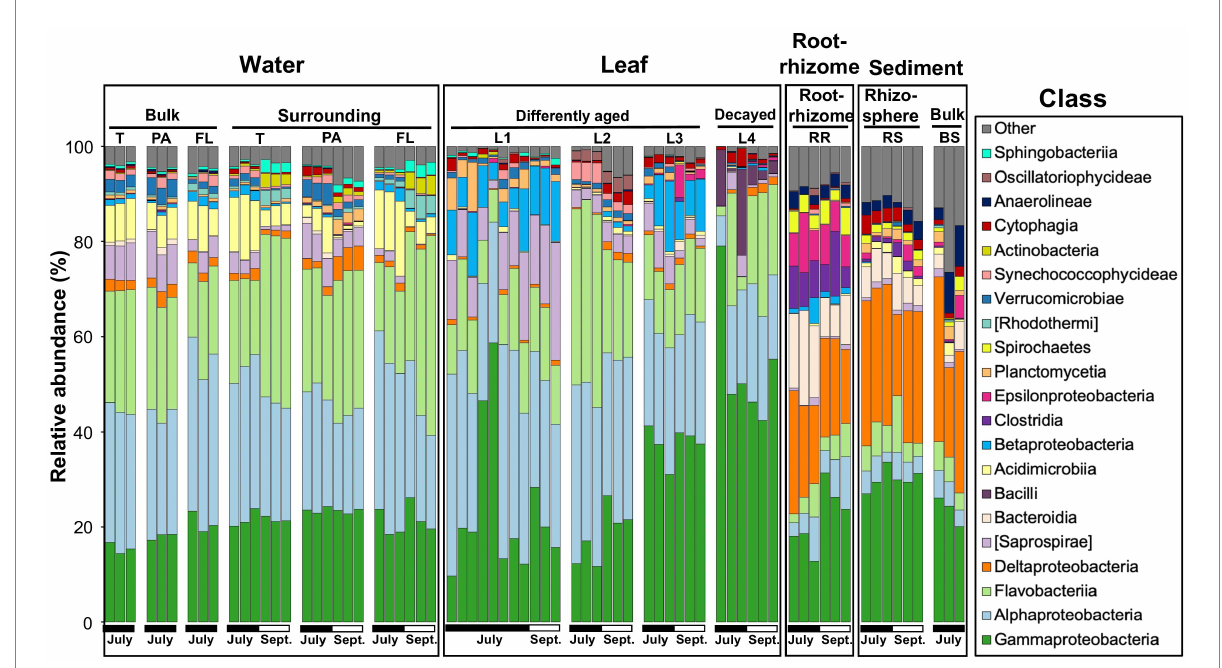
FIGURE 2 Microbial community composition of the eelgrass phyllosphere (differently aged and decayed leaves), rooting zone (the root-rhizome), surrounding environments (eelgrass surrounding water and rhizosphere sediment), and control environment (bulk water and sediment) at the class level in July and September. The class less than 2% was combined and referred to as “Other”. T, total (PA + FL); PA, particle-associated; FL, free- living; (L1–L3), differently aged leaves; L4, decayed leaves; RR, root-rhizome; RS, rhizosphere sediment; BS, bulk